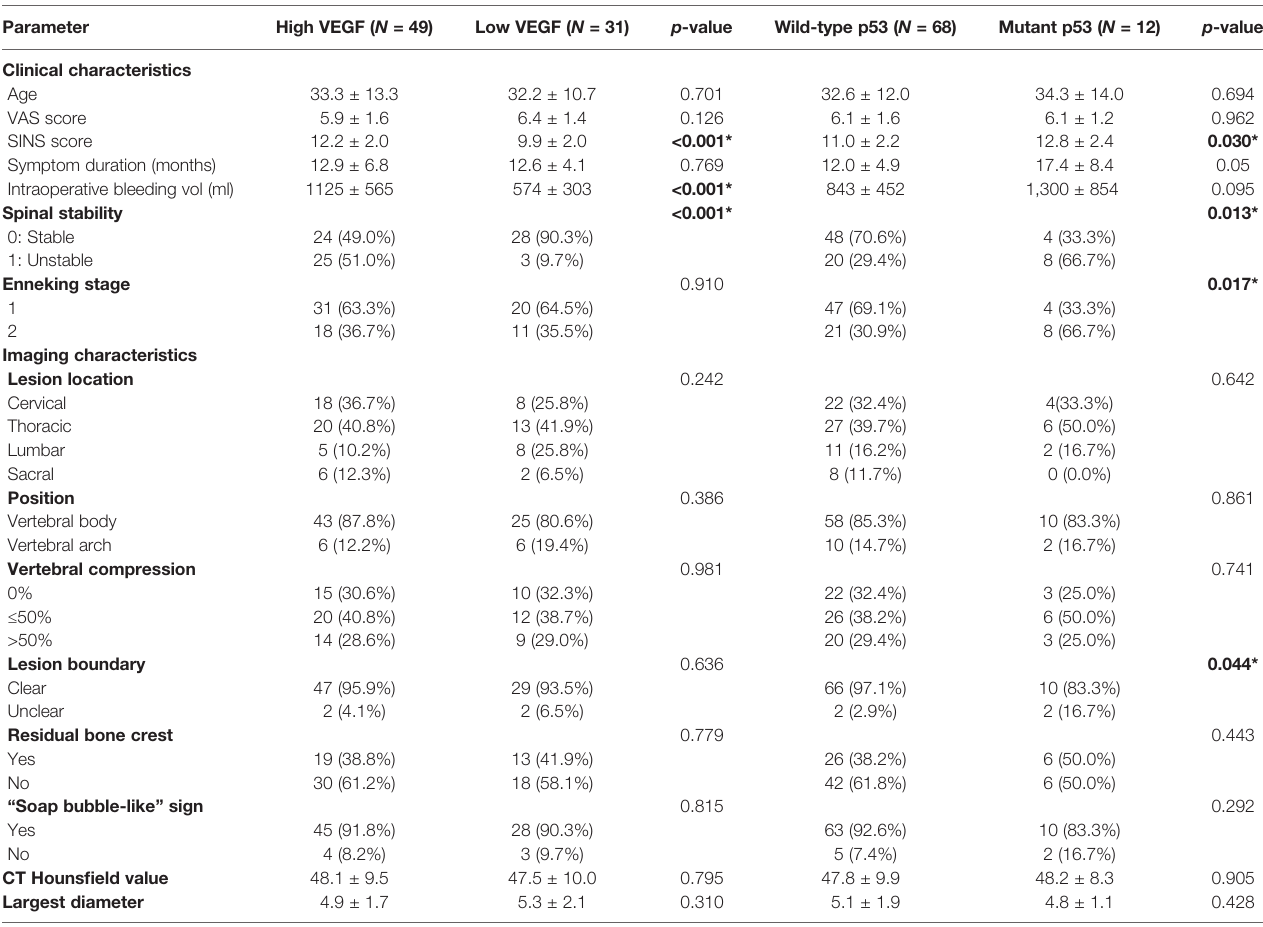
TABLE 1 | Clinical and imaging characteristics in high vs. low VEGF groups and wild-type vs. mutant p53 groups. Parameter Clinical characteristics